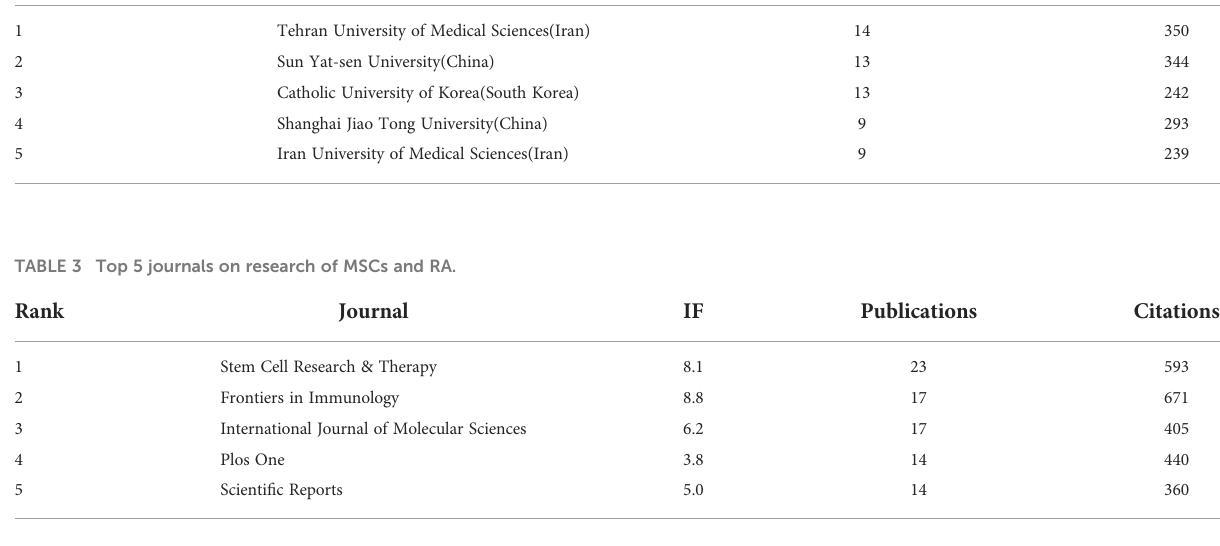
TABLE 2 Top 5 organizations in publications and their citations. Rank Organization